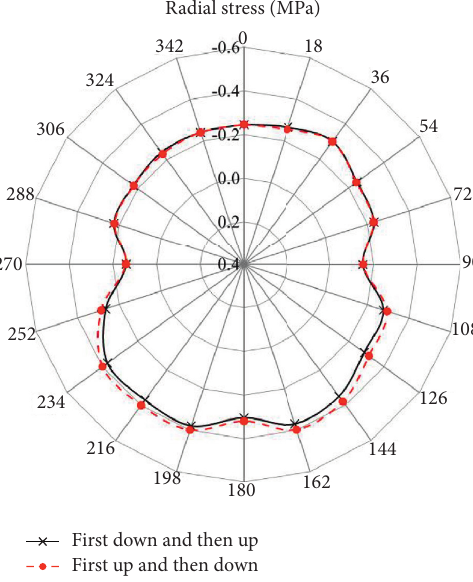
Figure 9: Radial stress of the upper tunnel lining.